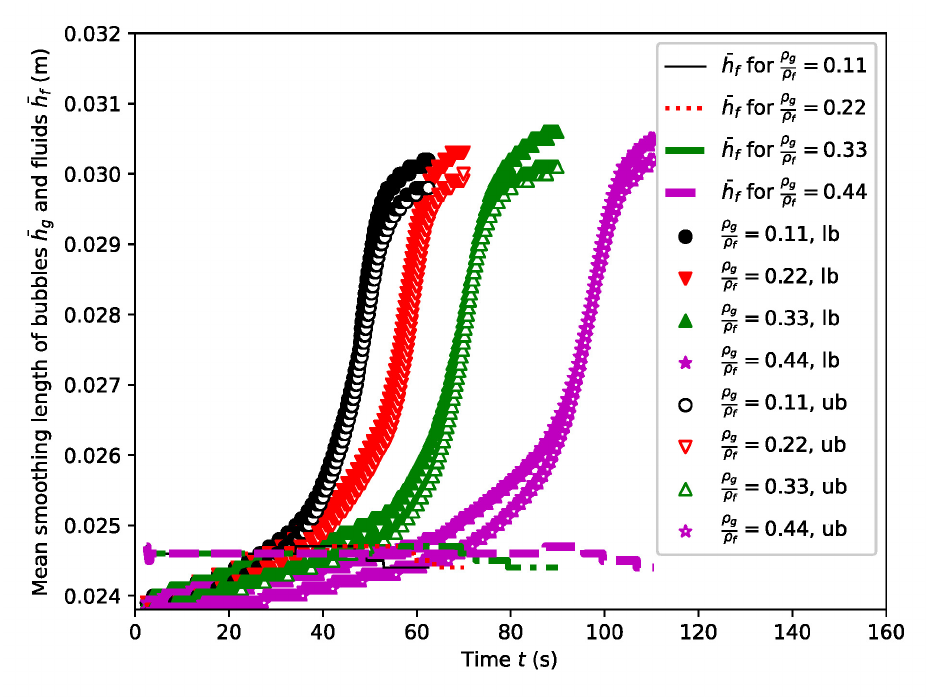
Figure 14. The mean smoothing length ¯ h of the two-bubble case for different density